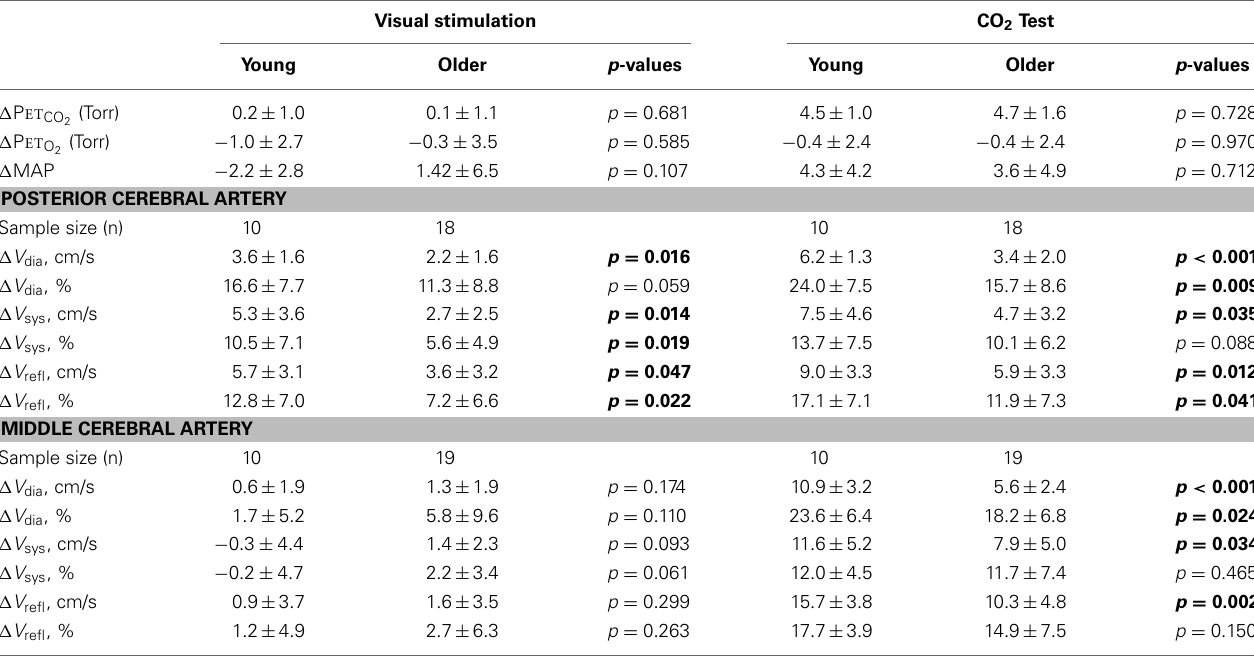
Table 2 | Changes in P ET CO , P ET O , MAP, and absolute and relative (i.e., percent) changes in cerebral waveform parameters for the posterior 2 2 and middle cerebral arteries in response to the visual stimulation and CO 2 test in the young and older groups. Visual stimulation CO 2 Test Young Older p -values Young Older p